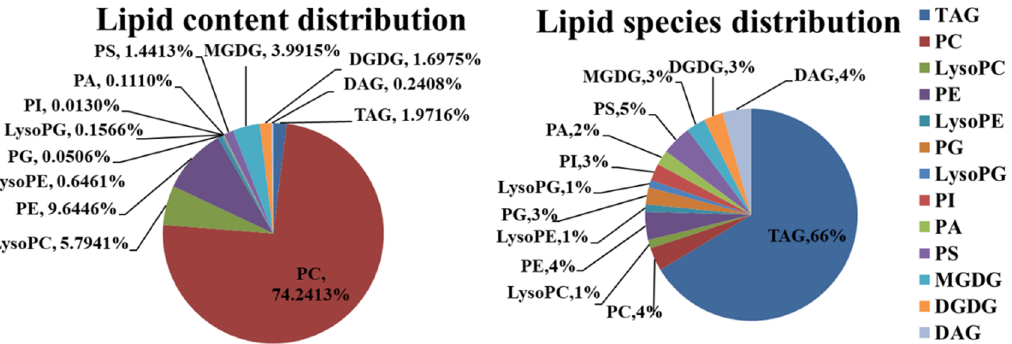
Figure 1. Map of lipid species and content distribution in tea leaves. A total of 615 lipid compounds were identified, and their species distribution and content distribution were shown in the figure.